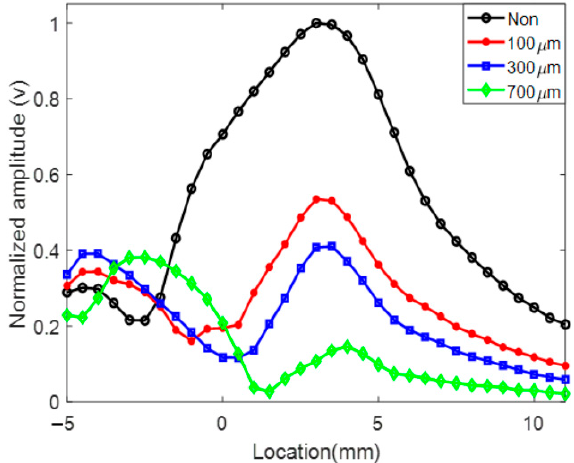
Figure 10. Experiment result of amplitude profiles of Circum defect type.